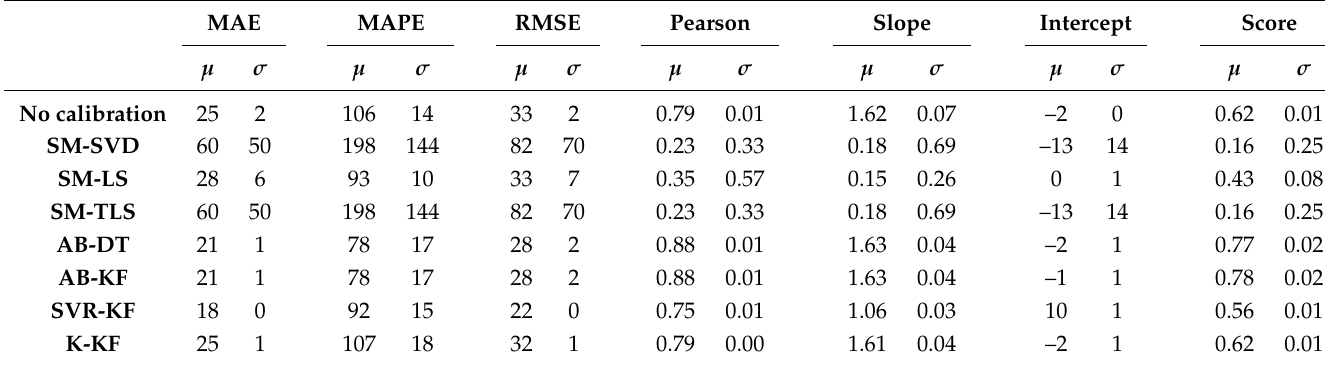
Table 13. Mean and standard deviation of each metric, computed on the entire time interval of study, over the 16 nodes of the network with the WGLI drift model, spikes and noise. The results with SM-(SVD, LS, TLS) are significantly influenced by the spikes and noise. The other strategies do not seem to provide more degraded results due to the noise and spikes although the performances were fairly unsatisfying from the start in Section